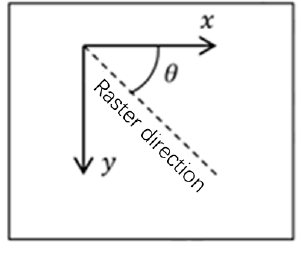
Figure 3. The axes and the rotation angle.